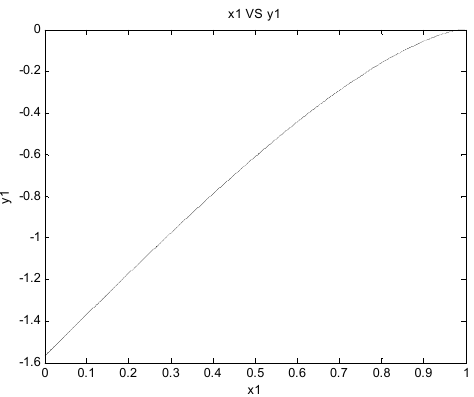
Figure 5. The curve of x1-coordinate mapping to y1-coordinate.